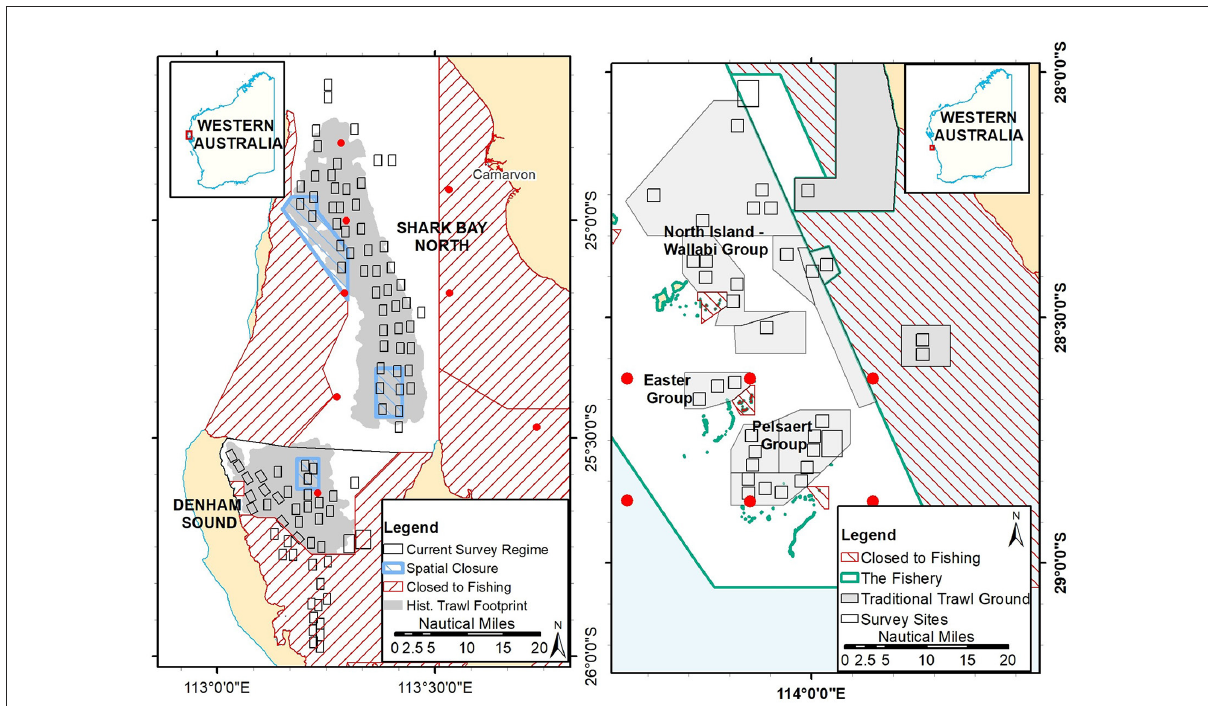
FIGURE1 Map of Shark Bay (left) indicating the two main scallop trawl grounds, spatial closures and location of annual survey “boxes”; and the traditional trawl grounds (shaded areas) in the Abrolhos Islands fishery (right) and location of annual survey “boxes”. The red hatched areas are permanently closed trawl areas (known as reef observation areas in the Abrolhos Is.) and the red dots are locations where SST was